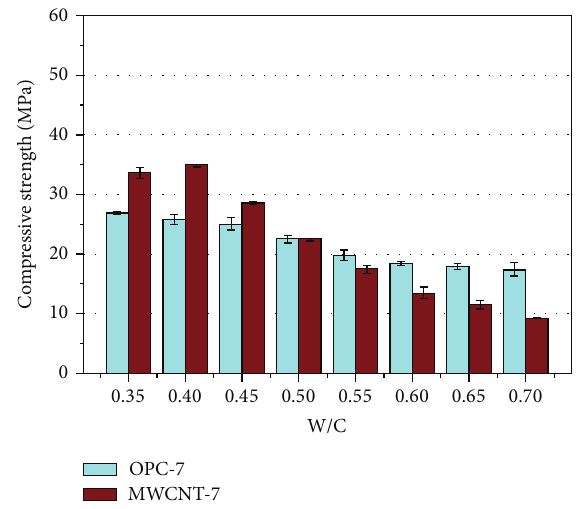
Figure 5: Compressive strength for various W/C ratios.